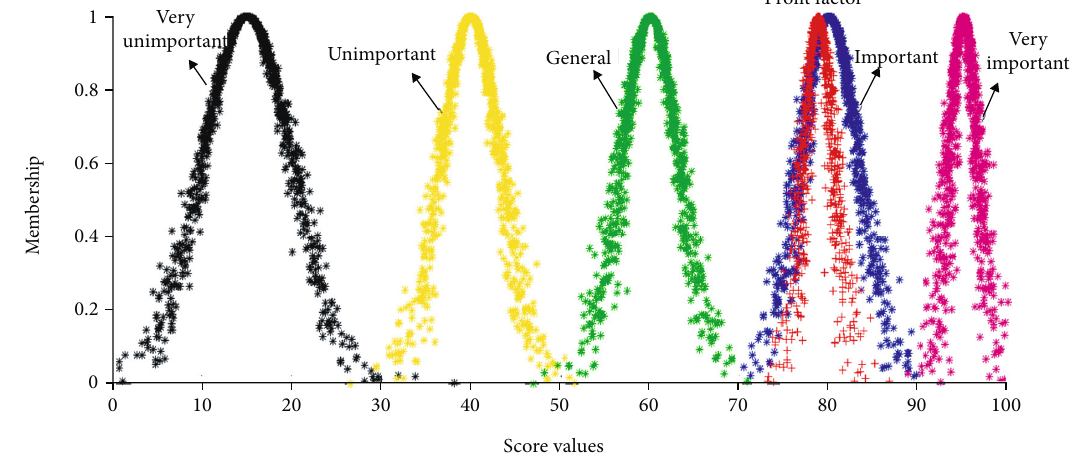
Figure 9: The comprehensive evaluation of pro fi t